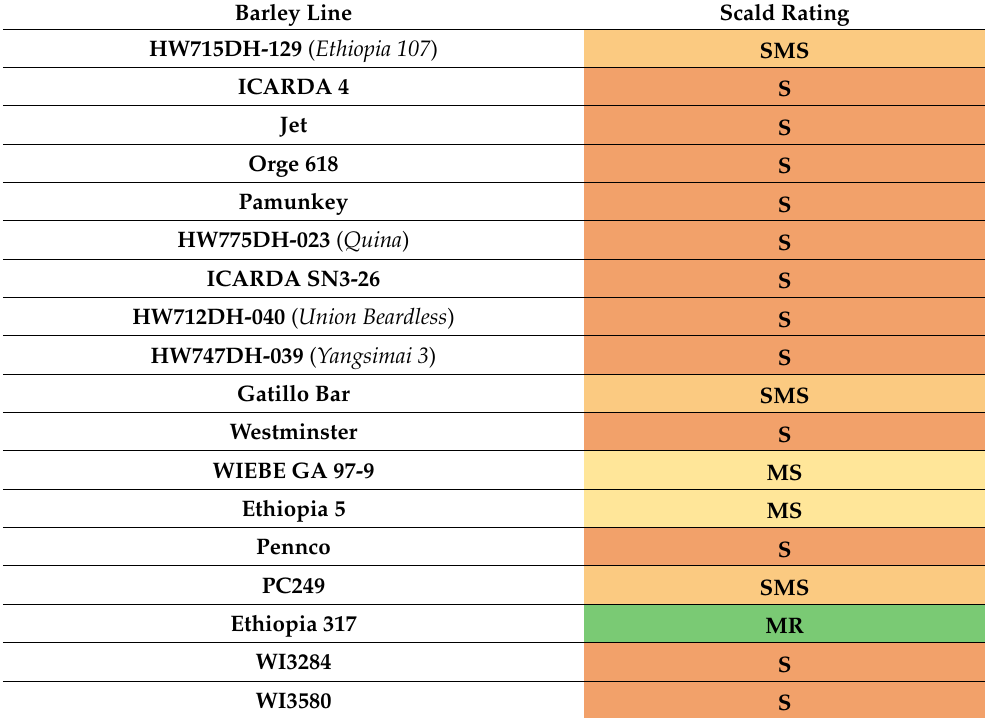
Table 3. Cont. Barley Line Scald